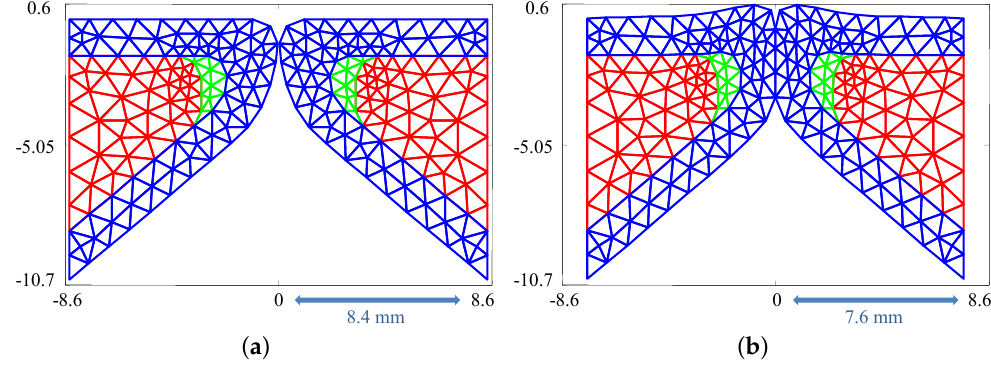
Figure 2. ( a ) Finite element triangulation used to simulate the silicone vocal folds; and ( b ) mesh deformation occurring as a result of medial compression. Red region: body; green region: ligament; and blue region: